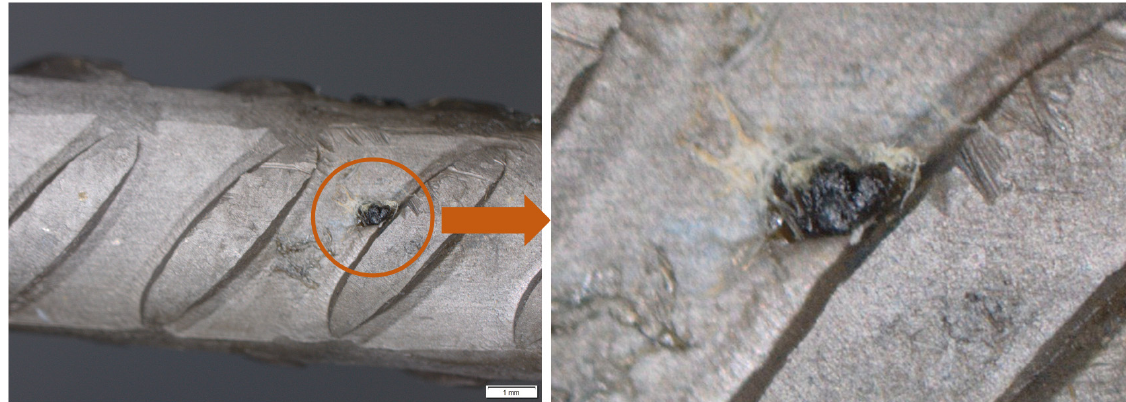
Figure 12. Detail of corrosion in the bar of specimen E11: overview ( left ) and close-up of a pit ( right ).